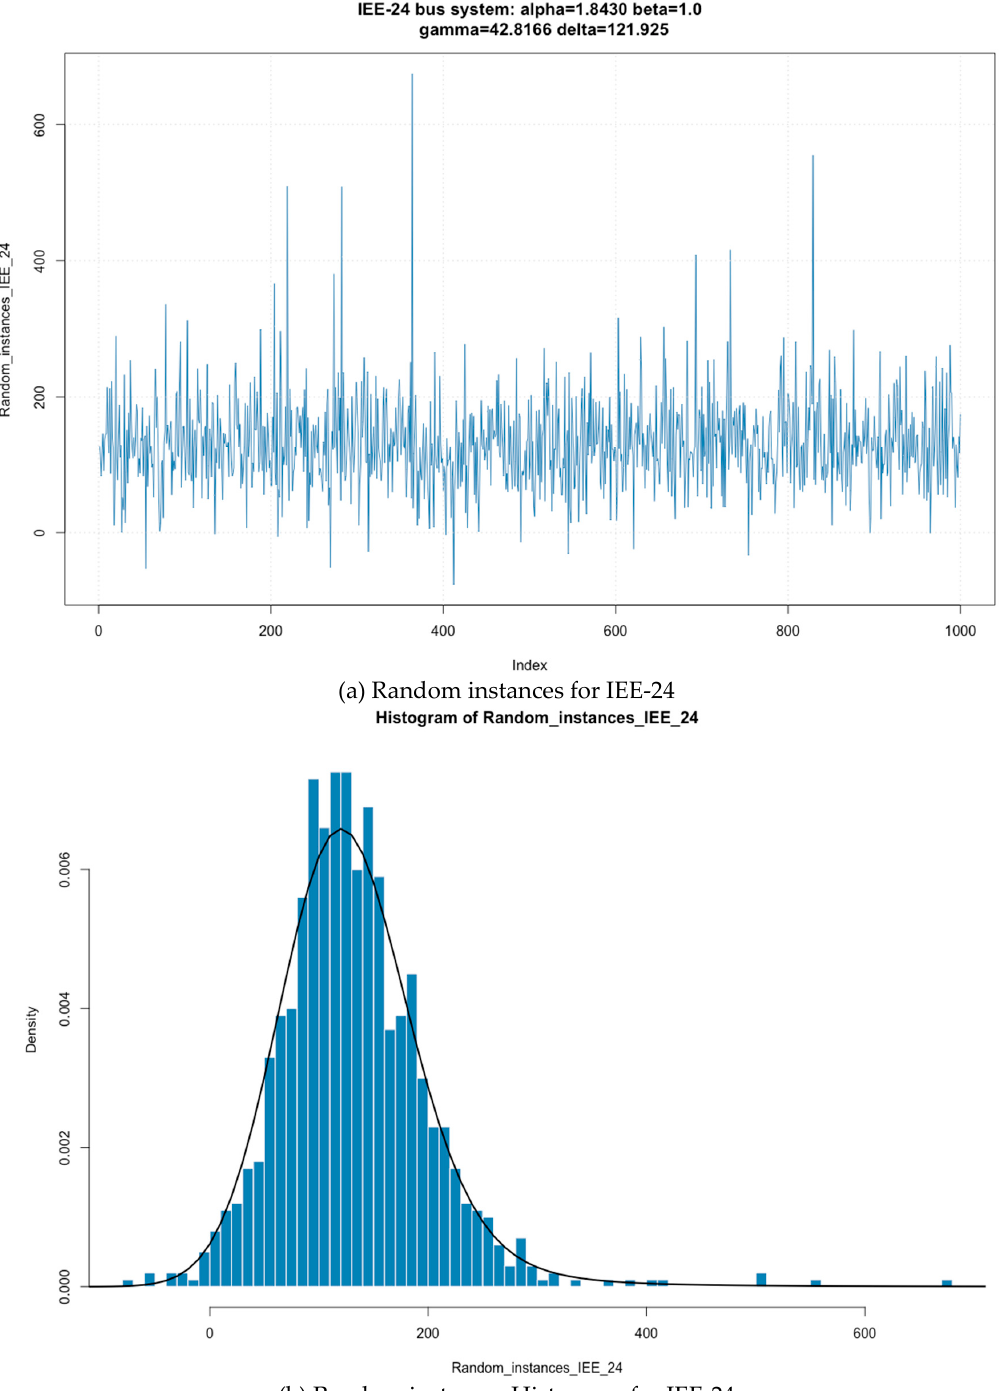
Figure 3. IEEE-24 bus system simulations.